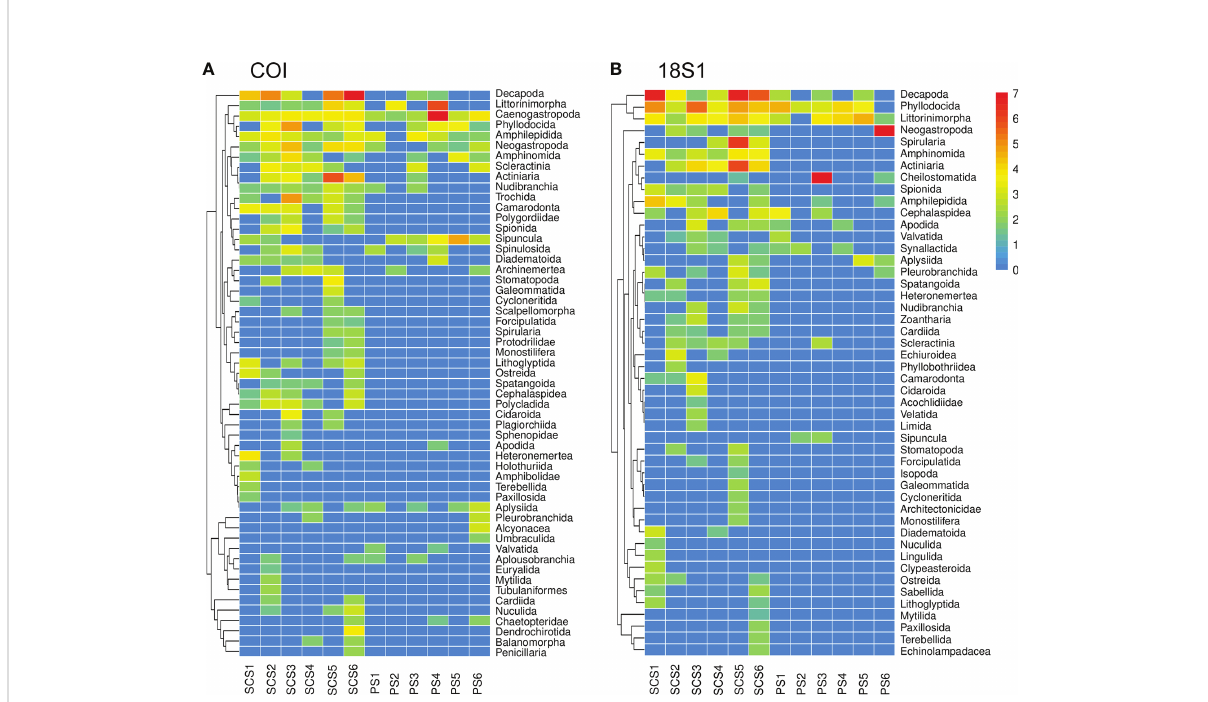
FIGURE 5 Heatmap showing meroplankton community composition for COI (A) and 18S1 (B) . Most of the classi fi cation levels are at the order level, family names were used when they were not assigned to any order temporally. Reads were fourth-root transformed and displayed in the legend.